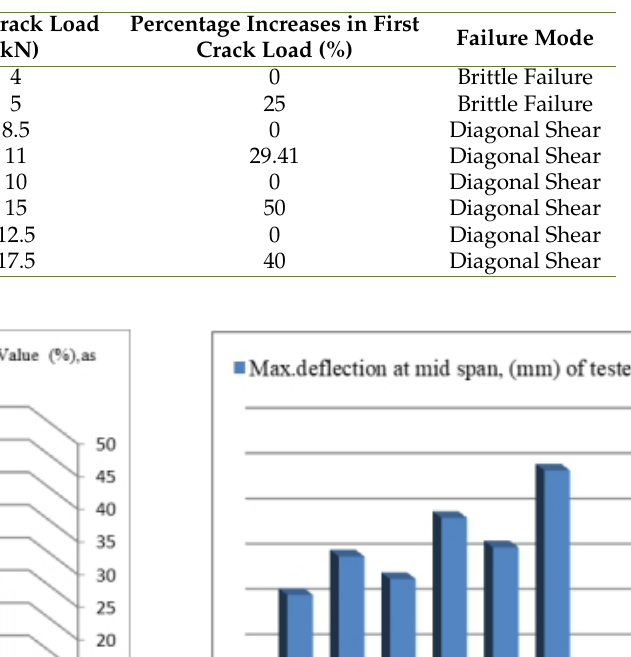
Table 7. First Crack Load Values and failure modes for Tested Beams